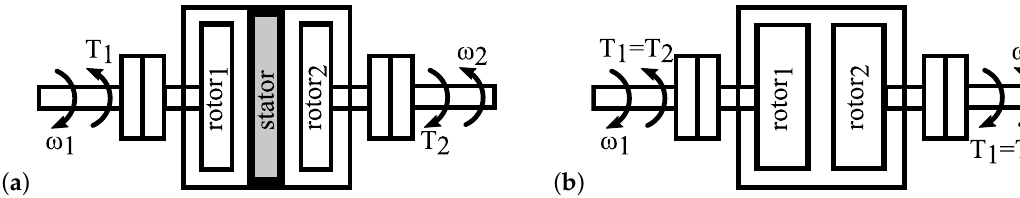
Figure 1. The general structure of the dual rotor machine: ( a ) machine with two rotors and a stator; ( b ) machine with two rotors and no